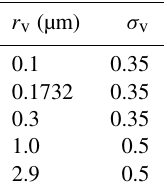
Table 3. Five log-normal modes used for particle size distribution in GRASP retrieval for AirHARP; r v is the volume median radius and σ v the geometric standard deviation (SD). In this kernel, other particle properties are free to be retrieved.